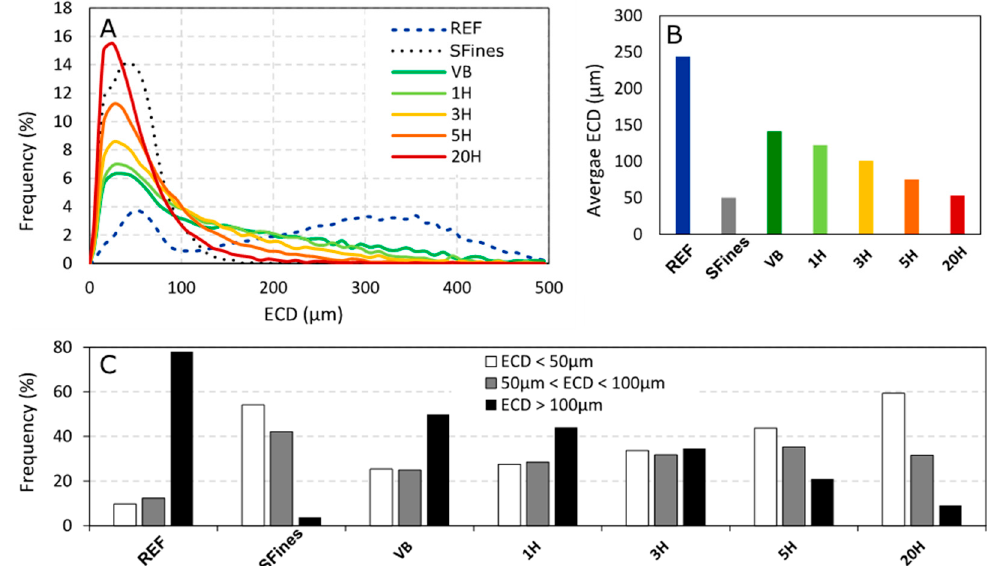
Figure 3. ( A ) Distribution of Equivalent Circle Diameter (ECD) for the different materials, obtained using L&W Fiber Tester+; ( B ) Comparison of the average values of ECD; ( C ) Detail of the partials frequencies of fibers detected per class of ECD.